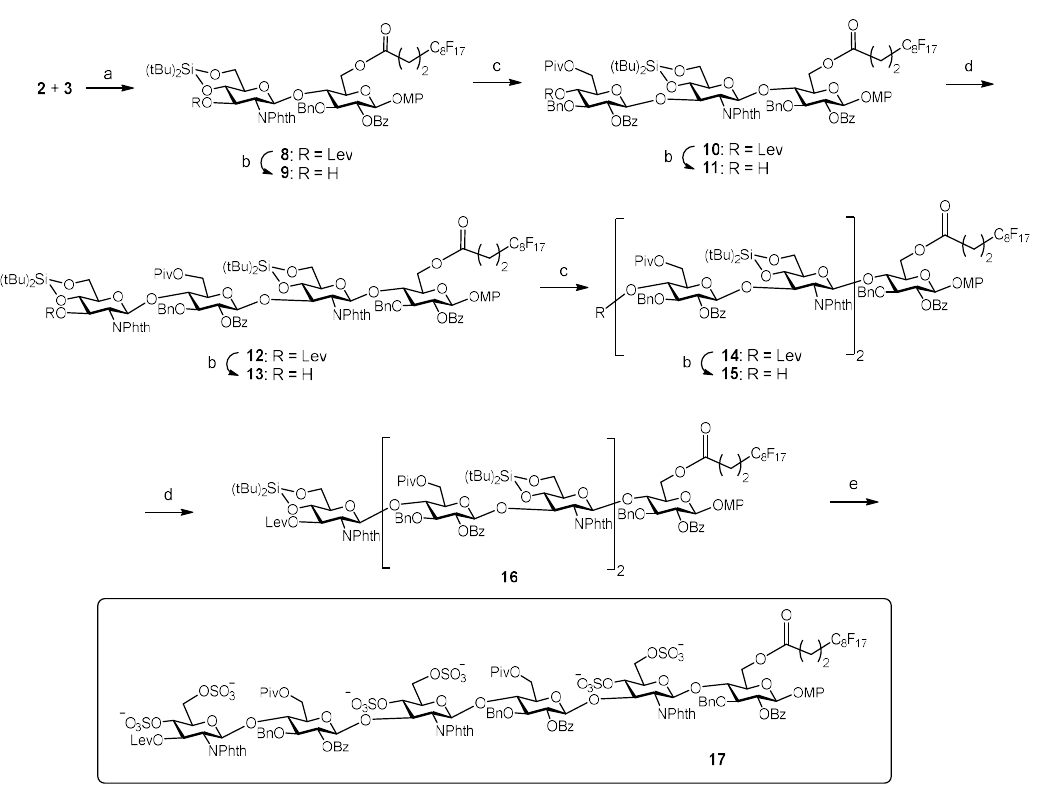
Table 1. IC 50 and K D,surf values for the interaction between fluorinated sugar 17 and midkine, basic fibroblast growth factor (FGF-2) and nerve growth factor (NGF) proteins. The IC 50 values were obtained from solution fluorescence polarization (FP) competition experiments while the K D,surf values were calculated from assays using fluorous sugar-coated microplates. Midkine FGF-2 NGF IC 50 (nM) 450 ± 30 6300 ± 1600 not